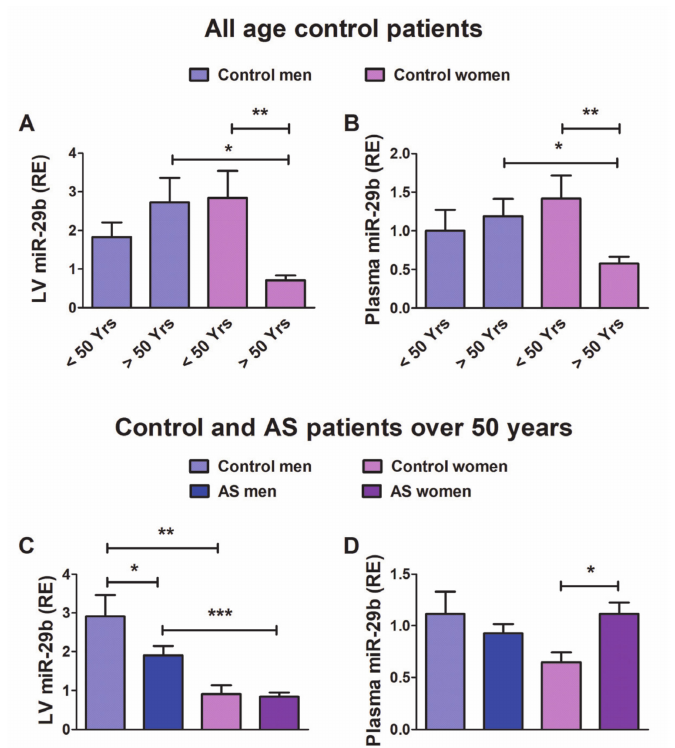
Figure 6. Expression levels of miR-29b in the LV tissue and plasma in patients. ( A ) relative miR-29b expression in the LV (RE vs. RNU6b) from control individuals under 50 years ( n = 6 men, n = 8 women) and over 50 years ( n = 11 men, n = 15 women) of age, and ( B ) in plasma (RE vs. Cel-39) from control individuals under 50 years ( n = 5 men, n = 8 women) and over 50 years ( n = 10 men, n = 13 women) of age. ( C ) miR-29b expression in the LV from control patients (11 men, 15 women) and patients with AS (45 men, 50 women) over 50 years of age, and ( D ) in plasma from control patients (10 men, 13 women) and patients with AS (38 men, and 46 women) over 50 years of age. Data are means ± SE. * p < 0.05, ** p < 0.01, *** p < 0.001 (Kruskal–Wallis followed by Dunn’s post hoc